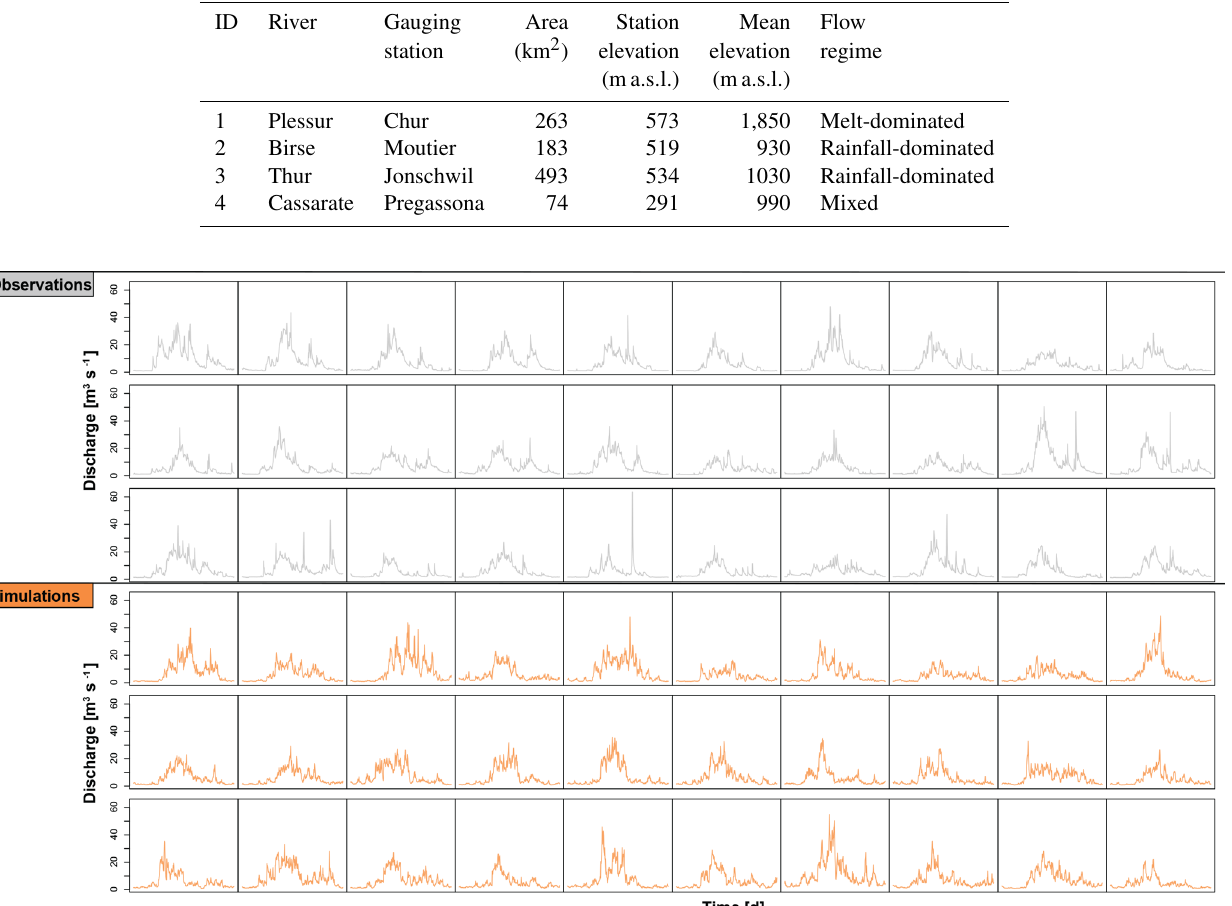
Table 1. List of catchments and catchment summary including ID, river name, gauging station, catchment area, station elevation, mean elevation, and flow regime.